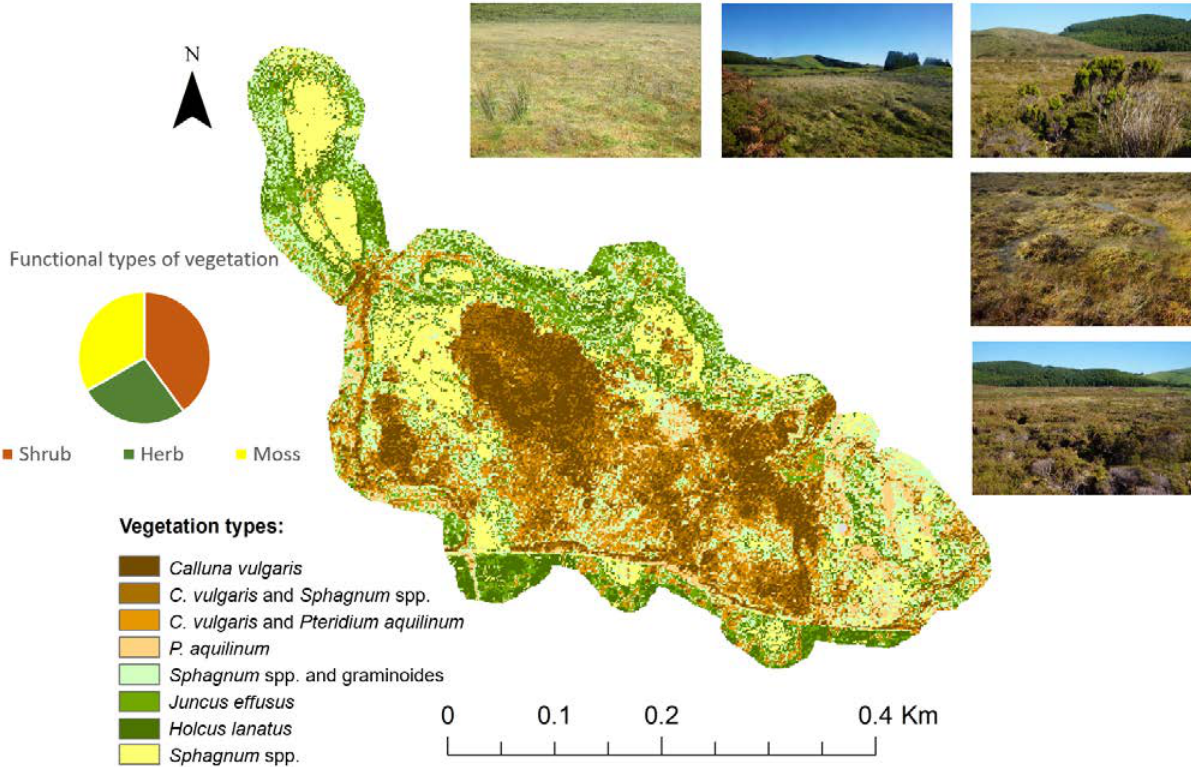
Figure 4. Vegetation map of the Criação do Filipe Peatland Complex. To distinguish between different vegetation units, we use Iso Cluster Unsupervised Classification, software ArcMap 10.6.1. The designation of vegetation types is based on the dominant cover